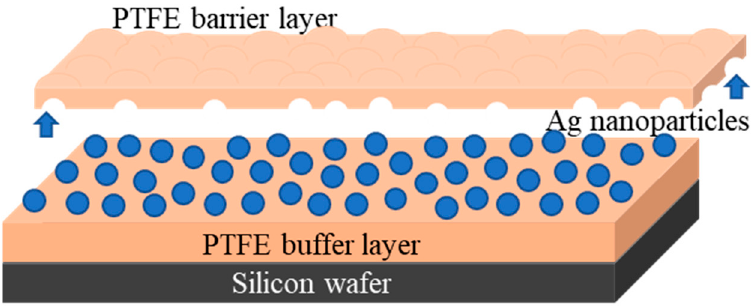
Figure 2. Illustration of the Ag-PTFE nanocomposite materials.